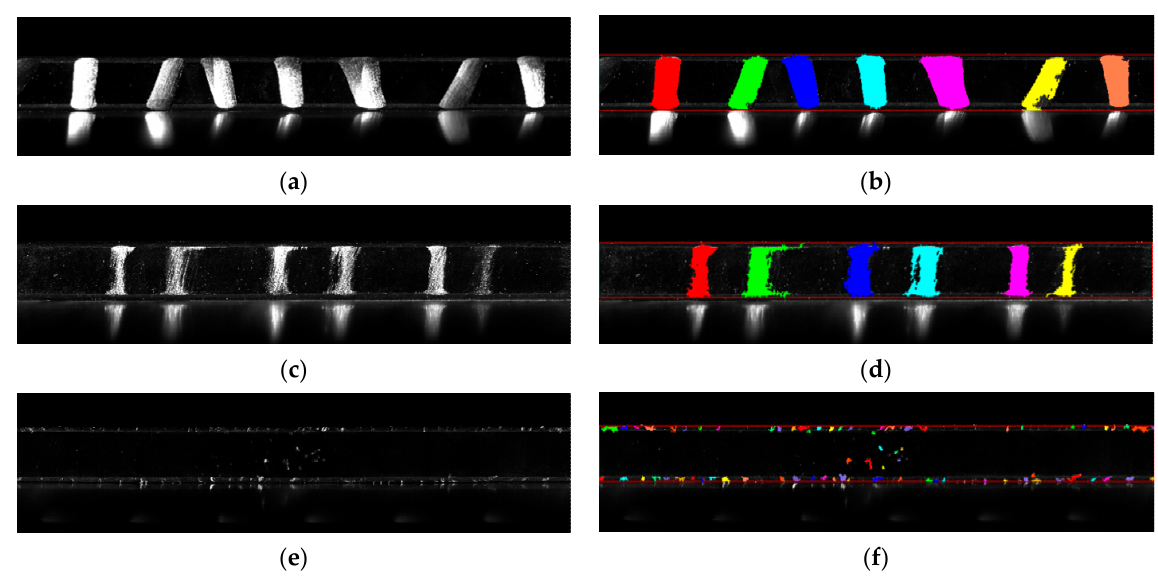
Figure 4. Test results obtained using image detection algorithm for different defects: ( a ) original image of over-grinding; ( b ) detection result of over-grinding; ( c ) original image of the scratch defect; ( d ) detection results of the scratch defect; ( e ) original image of the bruise defect; ( f ) detection results of the bruise defect.